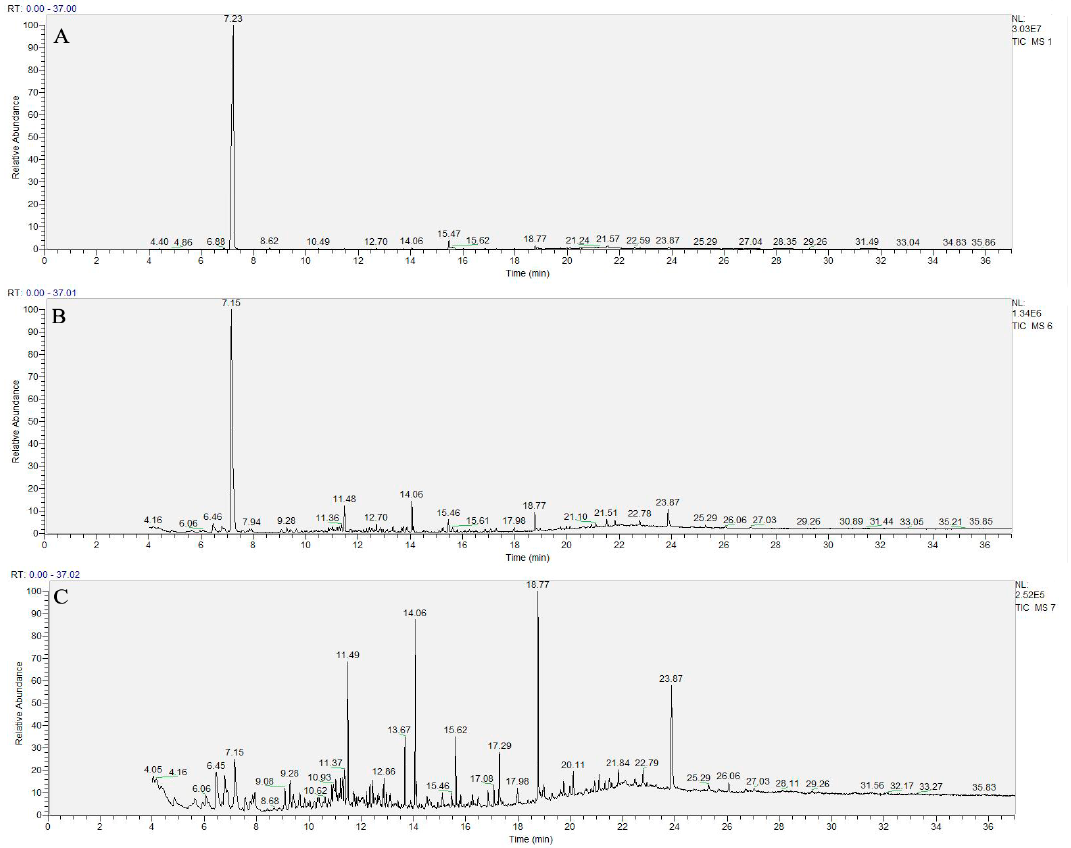
Figure 4. The UV - vis spectrum of the influent and the effluent under different external voltages ( A ) the influent X - 3B = 200 mg/L and ( B ) the influent X - 3B = 800 mg/L.